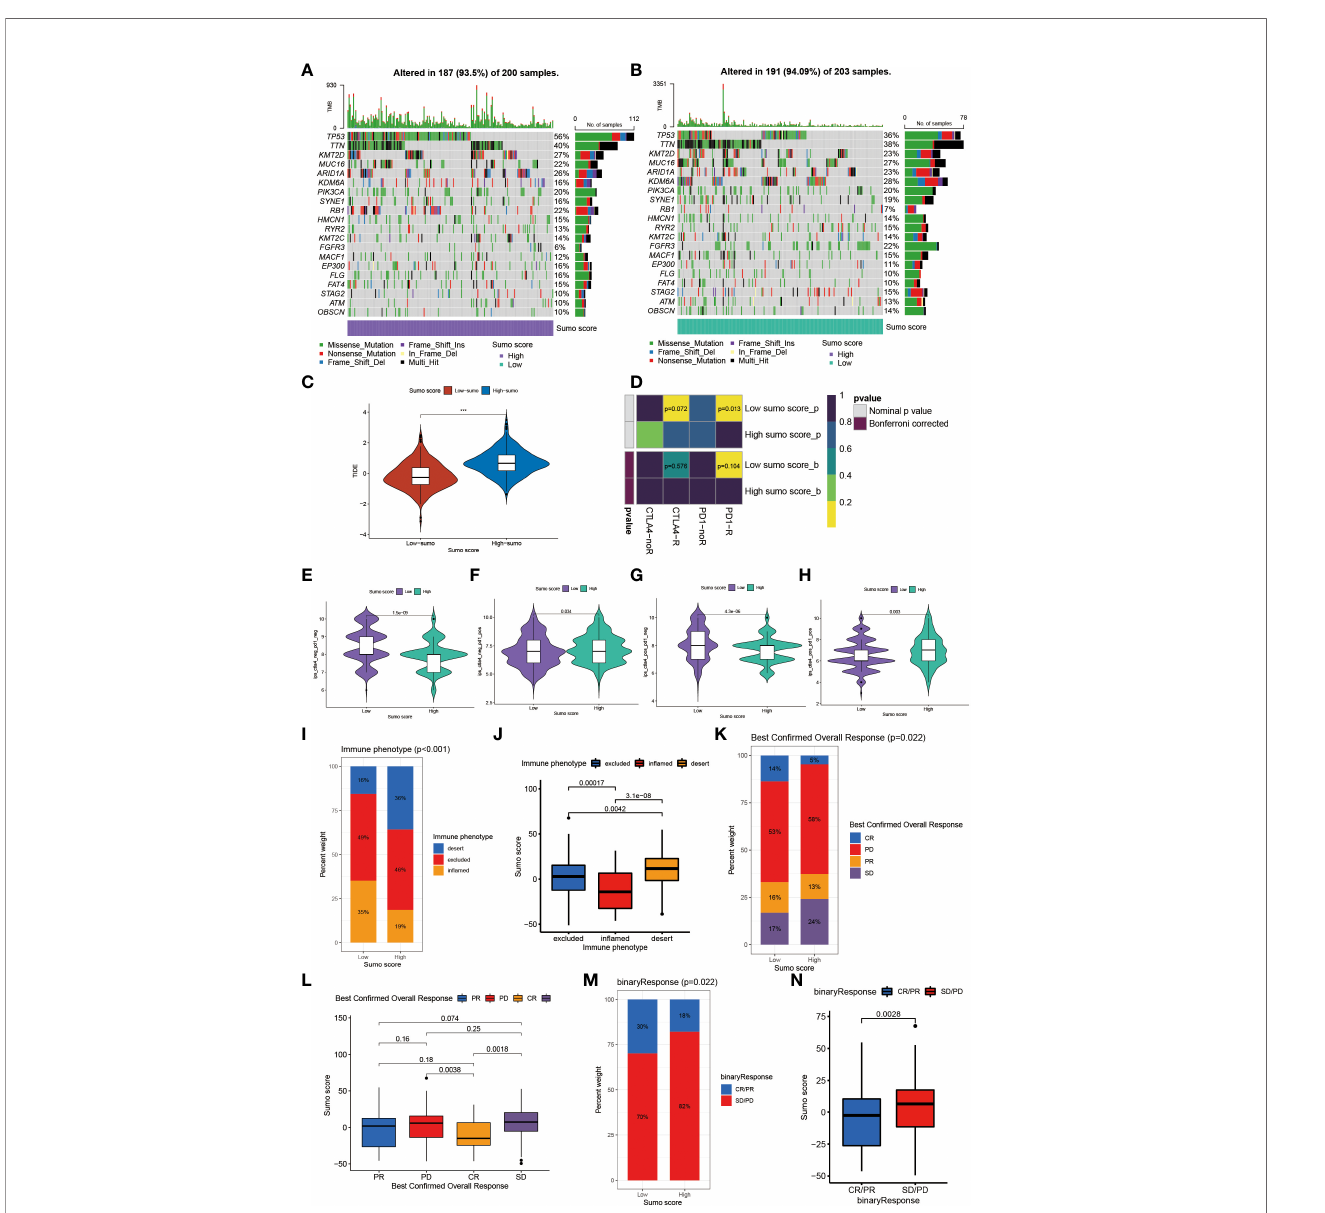
FIGURE 5 | The role of SUMOylation patterns in immunotherapy. (A, B) The waterfall plot of tumor somatic mutation established by those with high SUMO score (A) and low SUMO score (B) . Each column represented individual patients. The upper barplot showed TMB. The number on the right indicated the mutation frequency in each gene. The right barplot showed the proportion of each variant type. (C) Differences in the TIDE score between high and low SUMO score groups in meta-cohort (***P <0.001, Wilcoxon test). (D) The similarity of gene expression pro fi les between SUMO score and bladder cancer patients treated with immune checkpoint blockade (ICB). CTLA4-noR, patients no respond to anti-CTLA4 treatment, CTLA4-R, patients respond to anti-CTLA4 treatment, PD1-noR, patients no respond to anti-PD-1 treatment, PD1-R, patients respond to anti-PD-1 treatment. (E – H) The violin diagram showed the differences of response index between high and low SUMO score groups among four subgroups. (E) If no immunotherapy was conducted, the high SUMO score resulted in a poor prognosis compared to low SUMO score (P <0.001, Wilcoxon test). (F) If only anti-PD1 immunotherapy was used, the low SUMO score resulted in a poor prognosis compared to high SUMO score (P = 0.034, Wilcoxon test). (G) If only anti-CTLA4 immunotherapy was used, the higher SUMO score group tended to get a poorer therapeutic ef fi cacy compared to low SUMO score group (P <0.001, Wilcoxon test). (H) When anti-PD1 and anti-CTLA4 immunotherapy methods were simultaneously adopted, the high SUMO score group might get signi fi cantly better prognosis compared to low SUMO score group (P = 0.003, Wilcoxon test). (I) The proportion of three immune phenotypes in low or high SUMO score groups. (J) Differences in SUMO score among immune excluded, immune in fl amed and immune desert phenotypes in IMvigor 210 cohort (Kruskal – Wallis H test). (K) The proportion of four different immunotherapy responses in low or high SUMO score groups. CR, complete response; PD, progressive disease; PR, partial response; SD, stable disease. (L) Differences in SUMO score among four different immunotherapy responses in IMvigor 210 cohort (Kruskal – Wallis H test). (M) The proportion of two binary immunotherapy responses in low or high SUMO score groups. (N) Differences in SUMO score among two binary immunotherapy responses in IMvigor 210 cohort (Kruskal – Wallis H